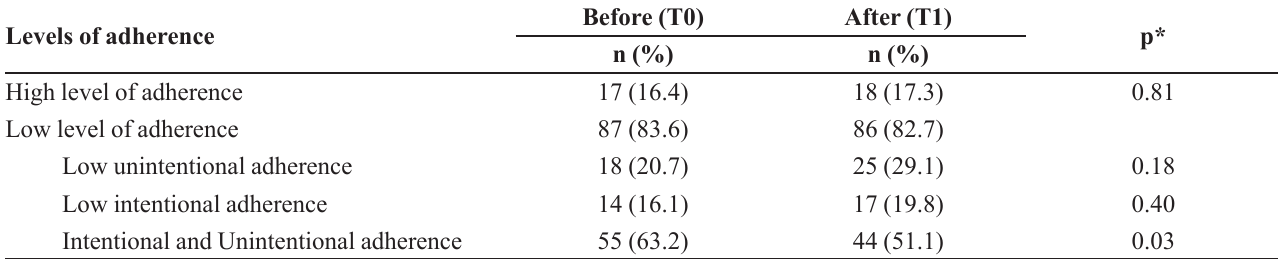
TABLE II – Patients adherence to drug therapy assessed by the Morisky scale questionnaire (Morisky< green, Levine, 1986) before and after the dispensation at the University Pharmacy of the Federal University of Goiás, 2013 (n = 104) Levels of